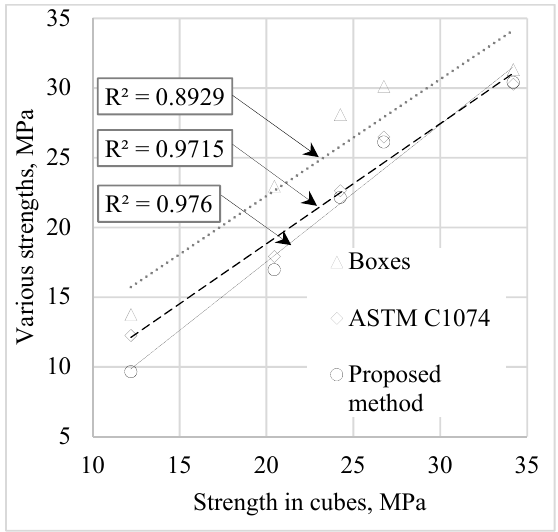
Figure 11. Calibration dependence of the above methods in relation to the compressive strength of cubic samples.